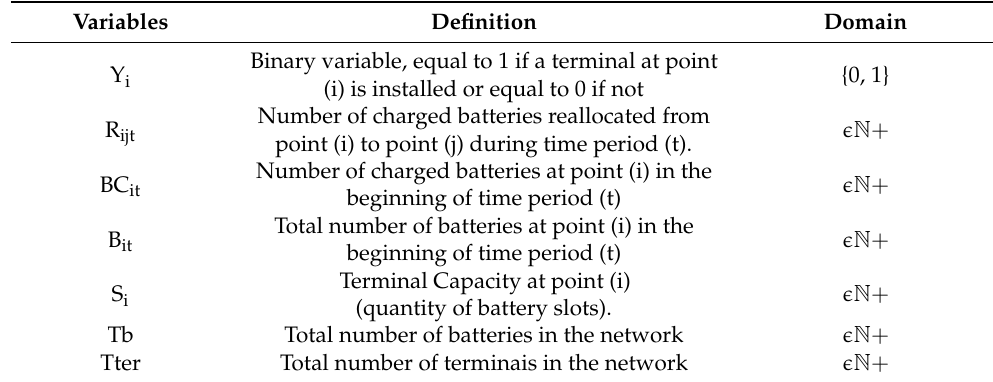
Table 3. Decision variables’